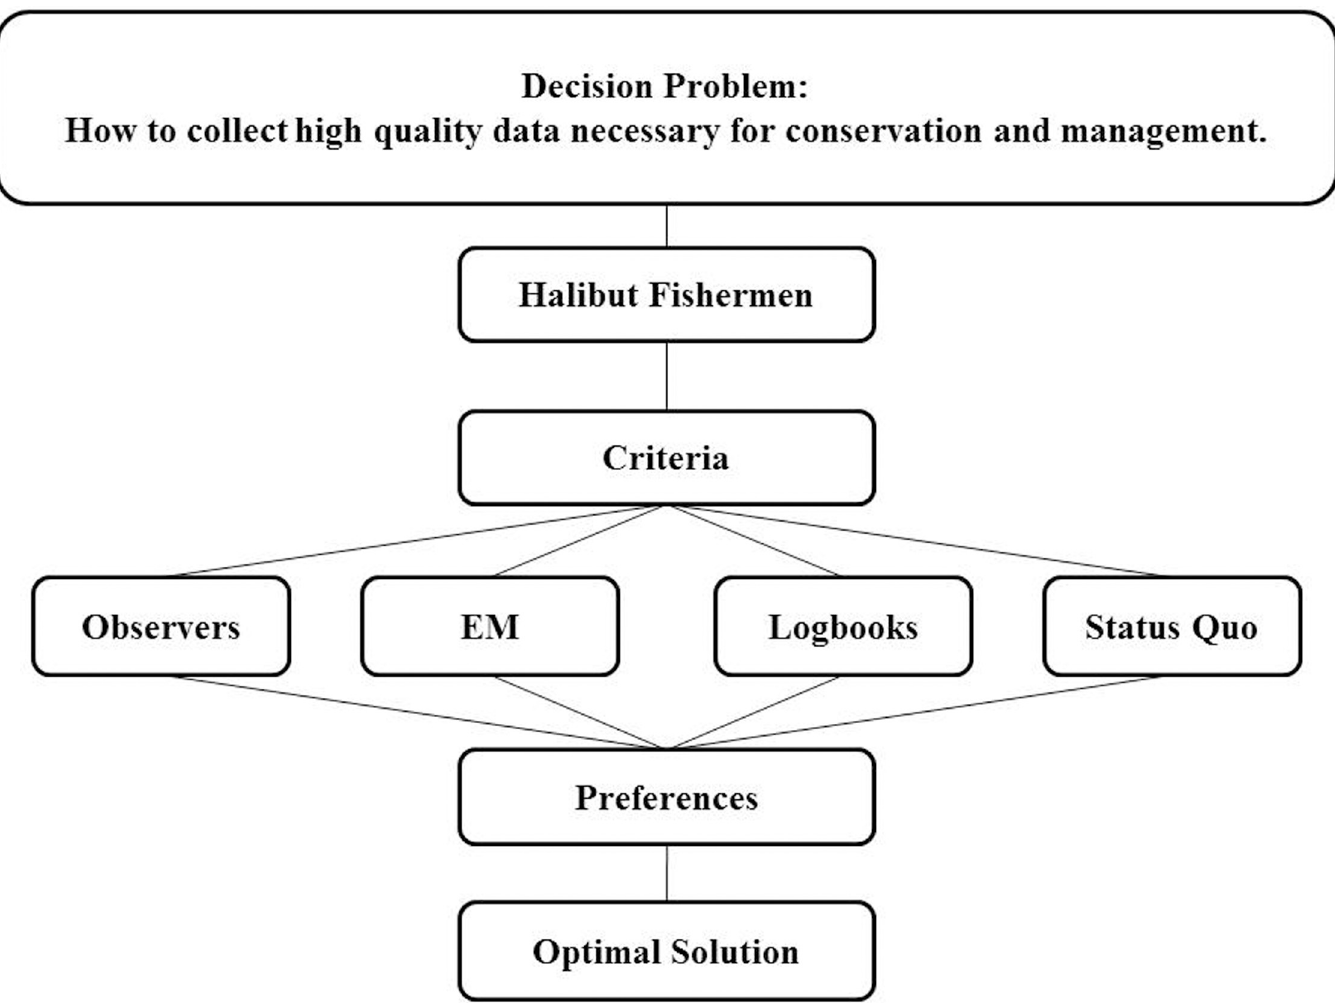
Fig 3. Schematic representation of the decision problem addressed in this research, with the overall goal at the top, followed by comparison criteria as they related to four data collection alternatives (observers, EM, logbooks, and the status quo), and preferences, resulting in a preferred solution (based on [38]).